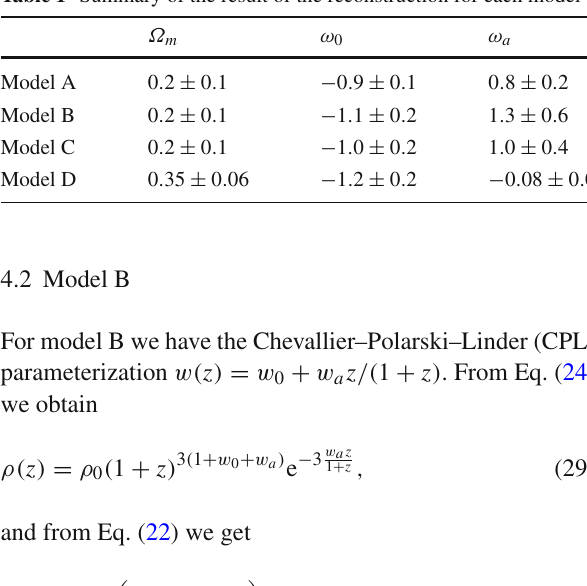
Table 1 Summary of the result of the reconstruction for each model